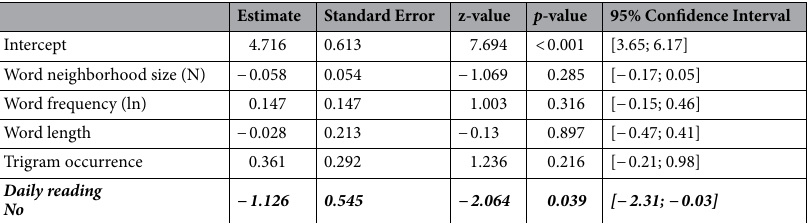
Table 3. Fixed-effects estimates from the GLME model (analysis 1). The dependent variable is ‘Target word reading accuracy’. The intercept estimate is the predicted value of the dependent variable when all independent variables are at 0 (continuous variables) or at their reference level (categorical variable). Reference level for the binary factor ”Daily reading” (representing reading proficiency) is ‘yes’. Factors showing a significant effect on reading accuracy are in bold font and highlighted in italic.